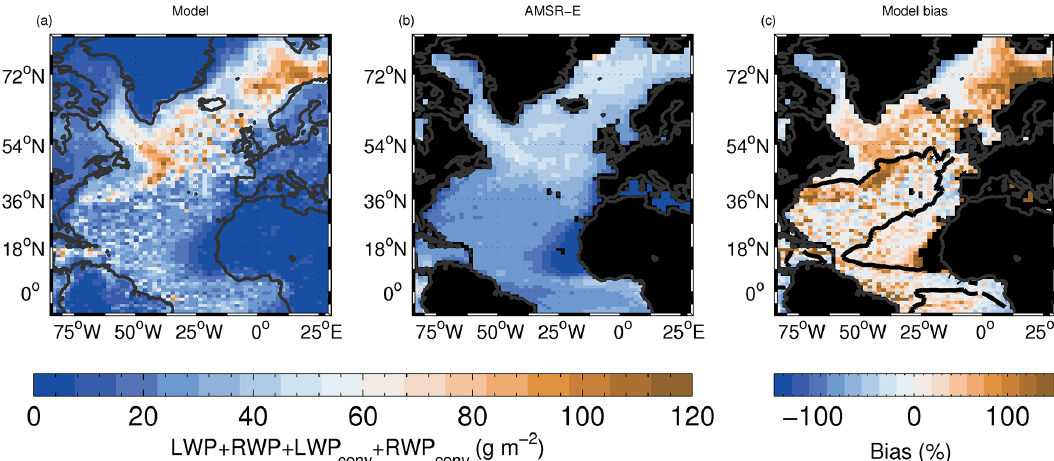
Figure D7. As for Fig. D6 except that the model and AMSR-E data have been filtered before time averaging to only include data points for which f LWP is greater than 0.99 (as in Fig. D2). Table D1. Model evaluation statistics for the various subregions using time-averaged data. See Gustafson and Yu (2012) for details of the NMBF and the NMAEF. r is the spatial correlation coefficient between the model and observed time averages. All values are area weighted to account for the variation in area of the model grid